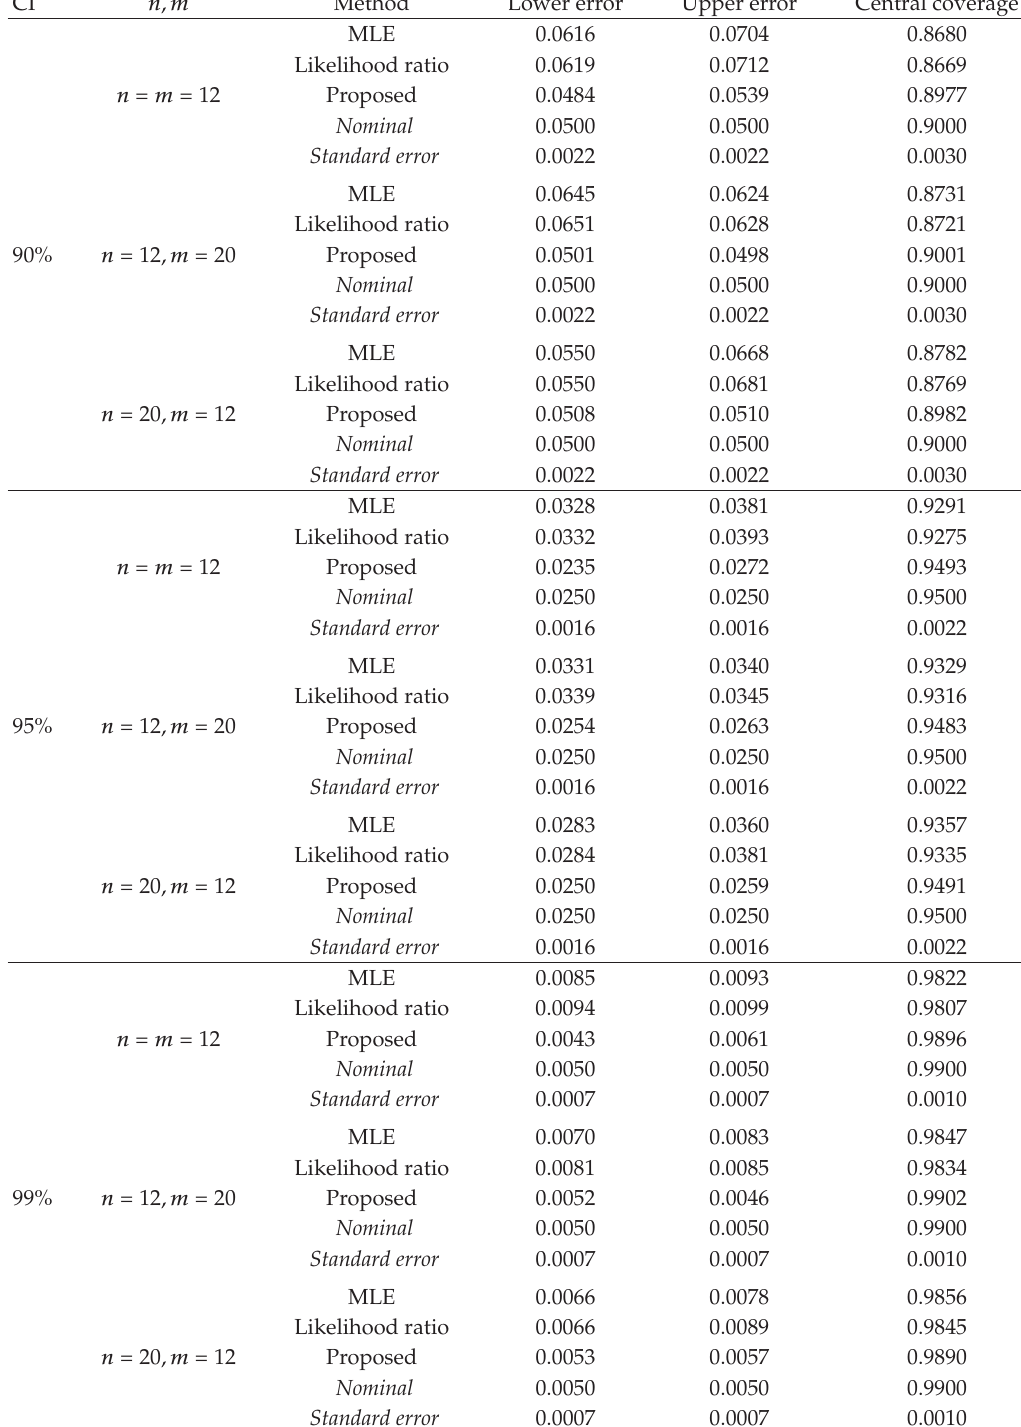
Table 8: Results for Simulation